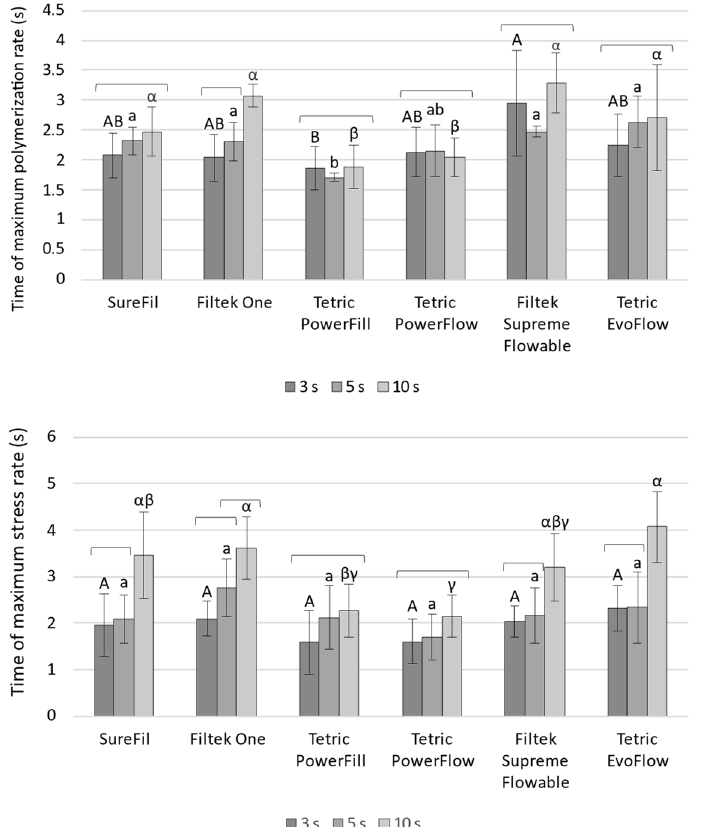
Figure 3. Time of maximum polymerization rate and time of maximum shrinkage stress rate (mean values ± 1 SD). Statistically similar values among curing protocols are connected with square brackets. Statistically similar values among materials are denoted by same uppercase, lowercase, and Greek letters for the 3, 5, and 10 s curing protocols, respectively.